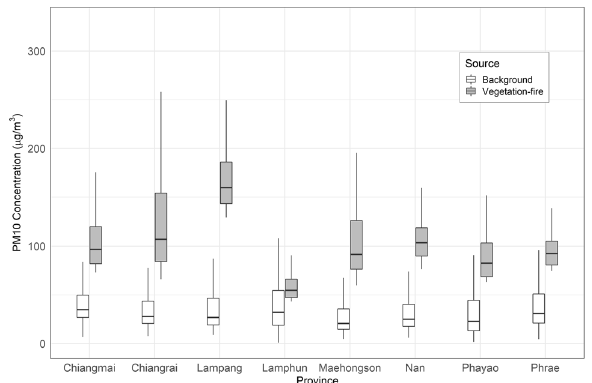
Figure 2. Boxplot of background and vegetation-fire-originated PM 10 concentration.